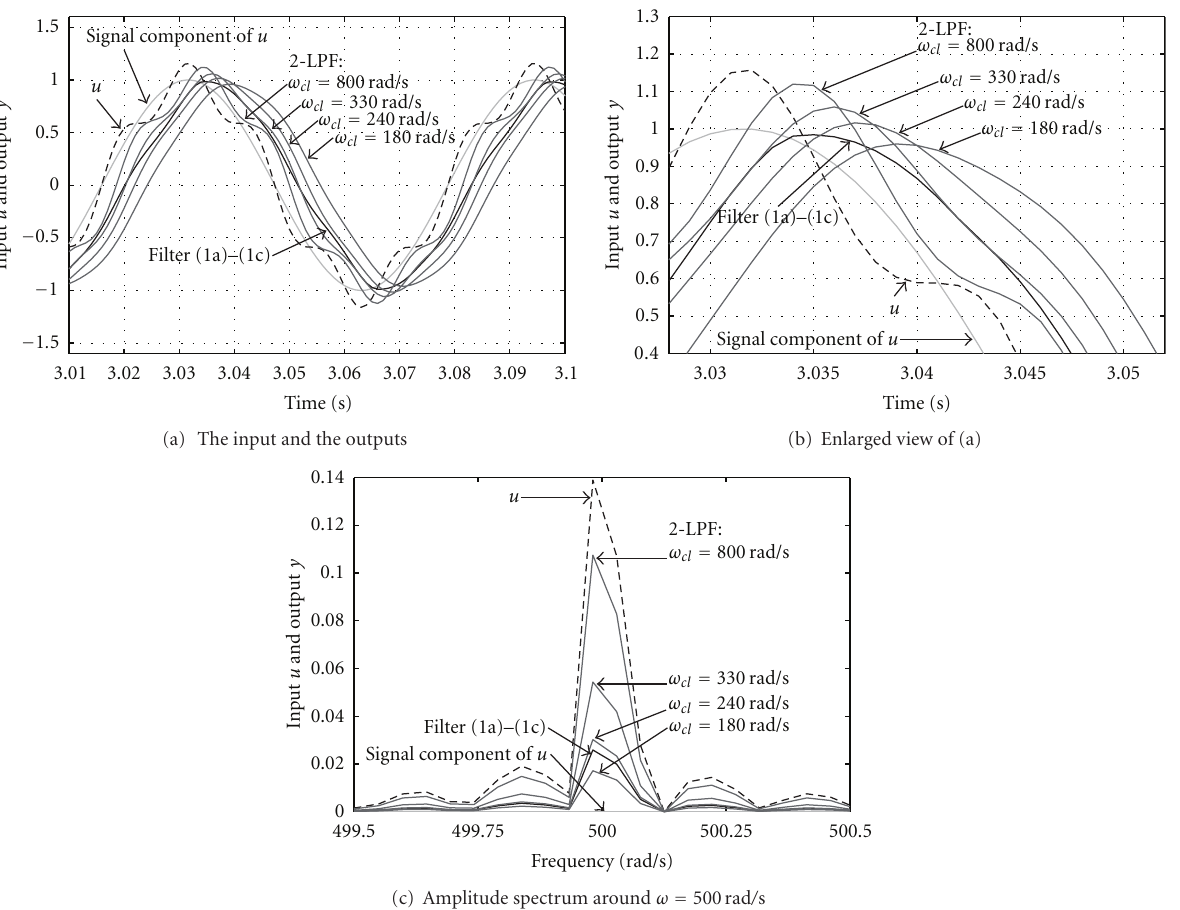
Figure 11: Comparison between the outputs of filter (1a)–(1c) with F = 9000s − 2 and α = 3 and 2-LPF with ω cl = 180, 240, 330 and 800rad / s for the input u = sin(100 t ) + 0 . 16 sin(500 t ). In (c), the amplitude of u at ω = 500rad / s is not exactly 0 . 16 presumably because of the limited length of sampled